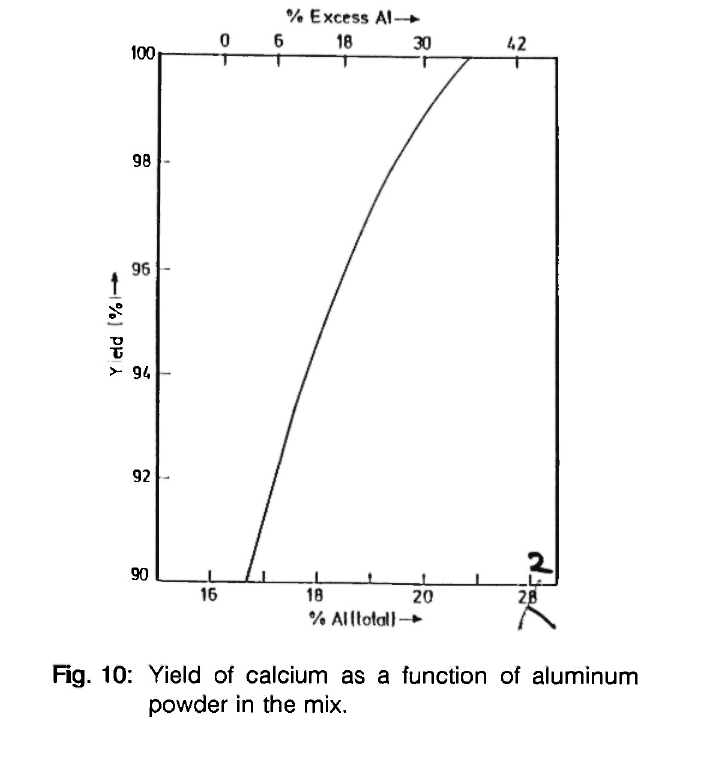
Fig. 10: Yield of calcium as a function of aluminum powder in the mix.